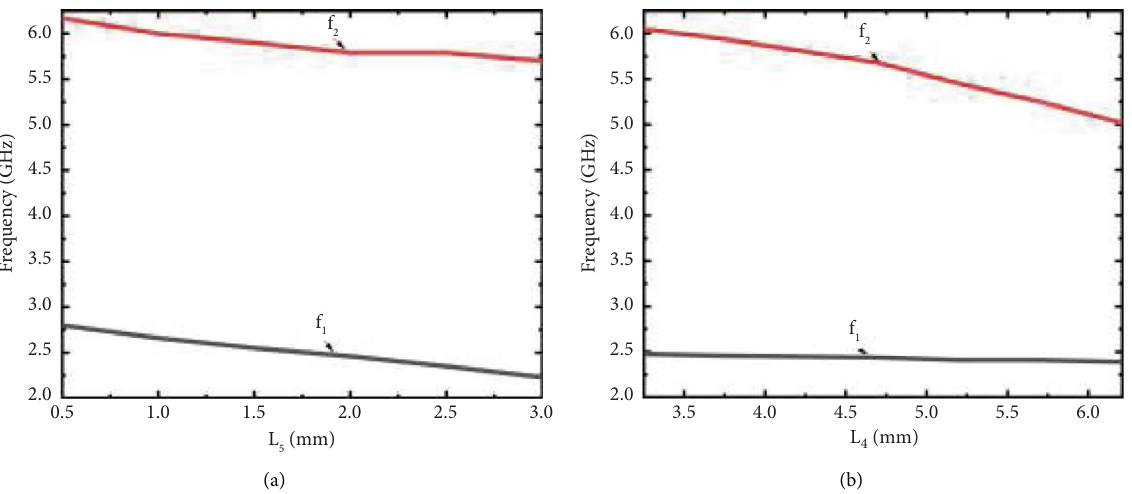
Figure 7: Resonant frequency with varied dimensions. (a) L